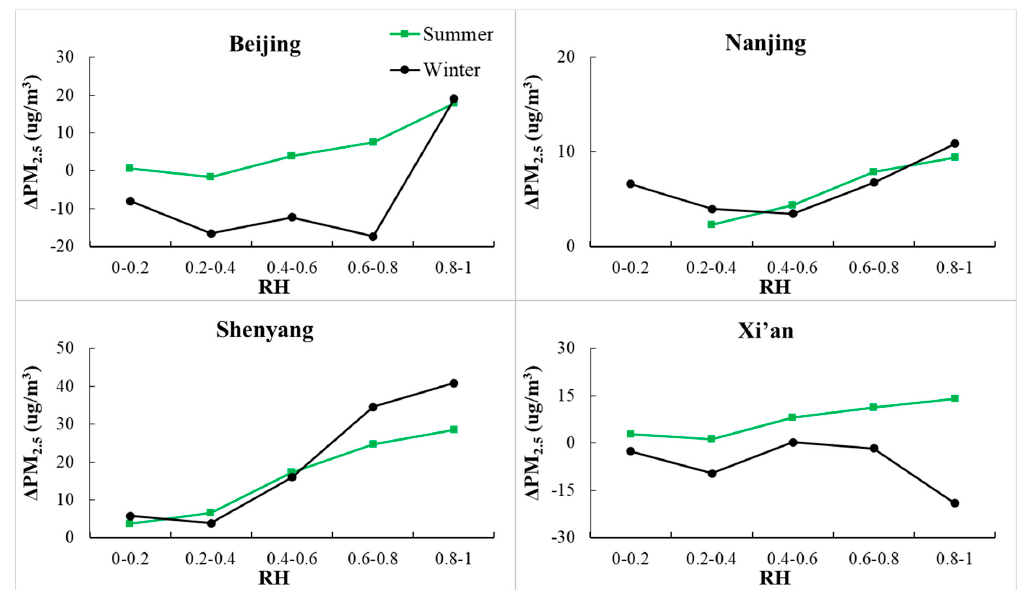
Figure 14. Variations in Δ PM 2.5 concentration (unit: μ g / m 3 ) as a function of relative humidity (RH) in Beijing, Nanjing, Shenyang, and Xi’an in summer (green curves) and winter (black curves). The Δ PM 2.5 concentration is the difference in PM 2.5 concentration between urban and rural areas.